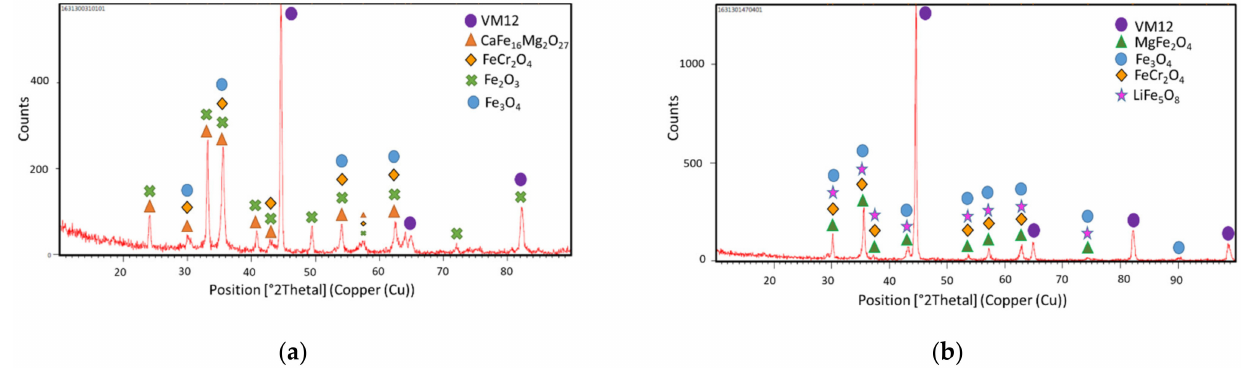
Figure 13. XRD analysis of VM12: ( a ) after “Solar Salt” in accelerated flow exposure at 500 ◦ C for 2000 h, ( b ) after 19% Ca(NO 3 ) 2 -46% NaNO 3 -35% LiNO 3 in accelerated flow exposure at 500 ◦ C for 2000